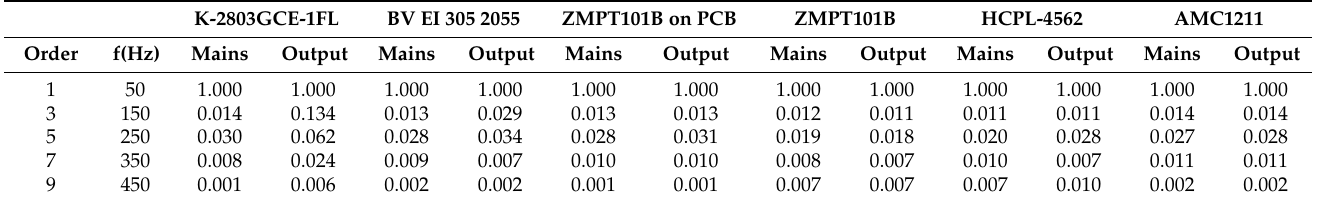
Table 1. Amplitudes of the first five odd harmonic components of the frequency spectrum of the waveforms normalized by the value of the amplitude of the first harmonic component.